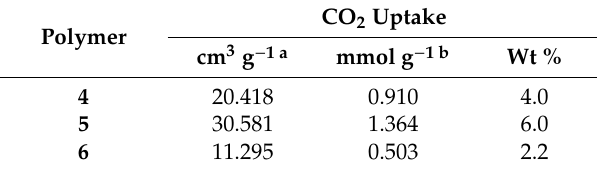
Figure 6. CO 2 adsorption isotherms of polymers 4–6 . Table 6. CO 2 adsorption capacity of polymers 4–6 at 323 K and 40 bar.